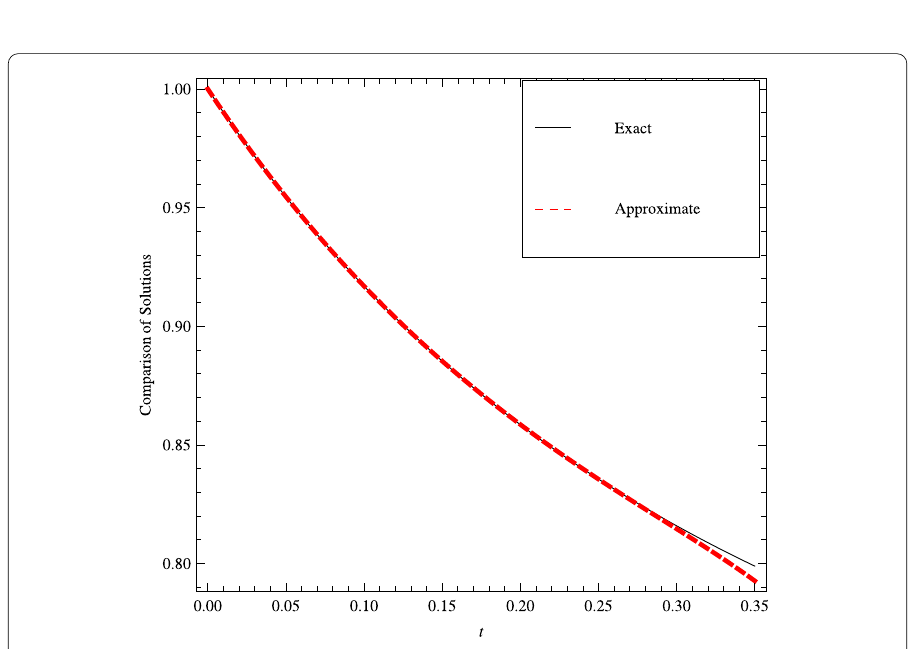
Figure 8 Comparison of the 4th term MHATM solution and the exact solution of the TFNWS equation when λ = 1